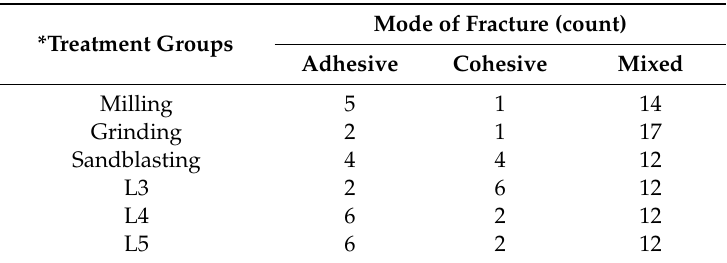
Table 8. Summary of fracture mode patterns.